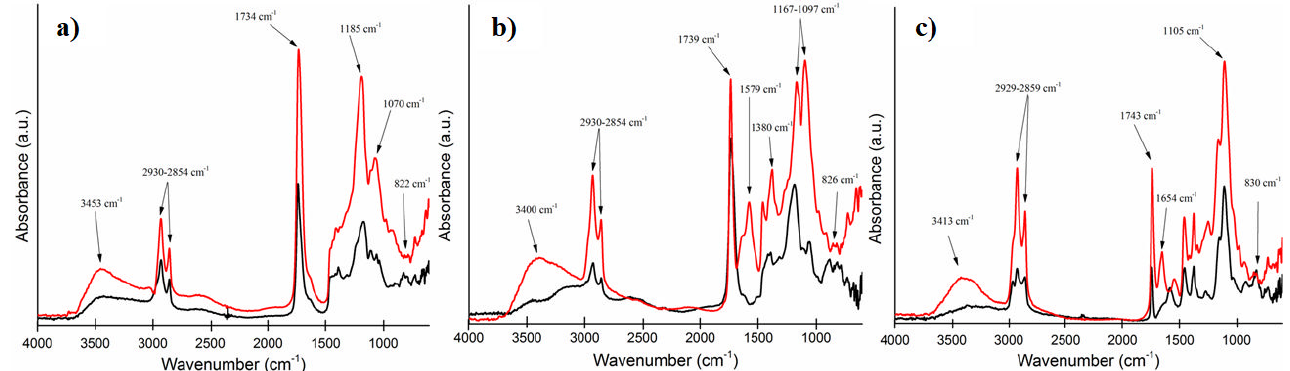
Figure 2. FTIR spectra for the ELO-based systems (initial formulation—black line, final materials—red line): ( a ) ELO_CA_W, ( b ) ELO_CA_THF, ( c ) ELO_D.